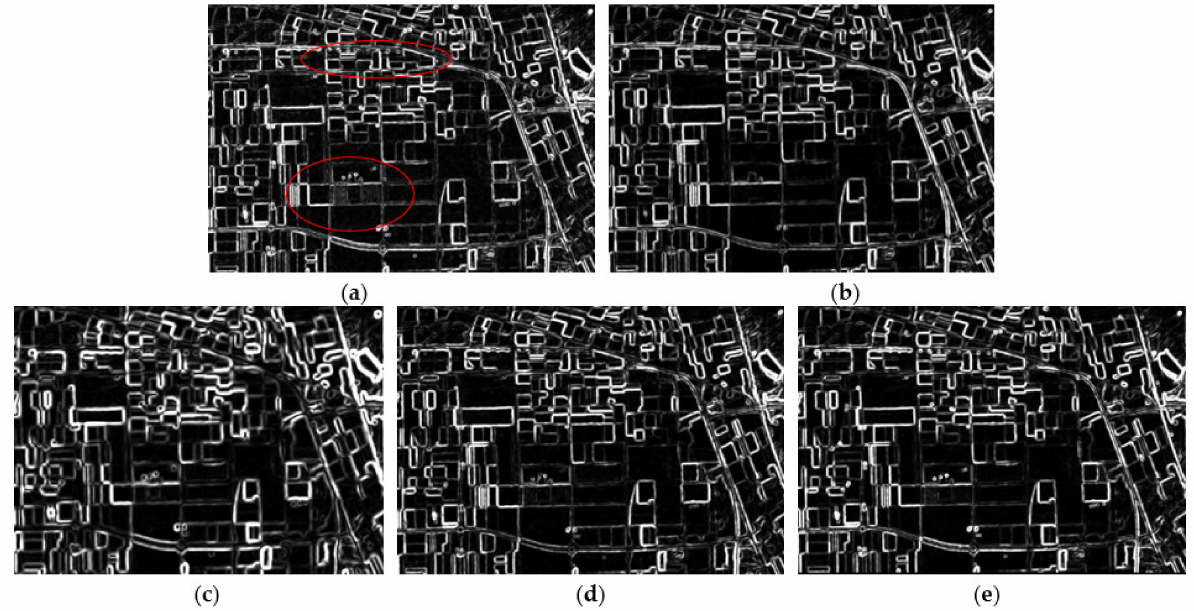
Figure 4. The edge maps obtained by the CFAR detector: ( a ) the edge map of the speckled image shows many “false edges” in homogeneous areas; ( b ) the edge map of the refined-Lee-filtered data, where false edges are removed, but some fine edges and point targets are missing; ( c ) the edge map of the NL-means-filtered data, where edges are retained well, but some point targets are still not retained; ( d ) the edge map of the NL-means-filtered data, where some point targets are still not retained; and ( e ) the edge map of the NWLMMSE-filtered image shows a better result in retaining edges and